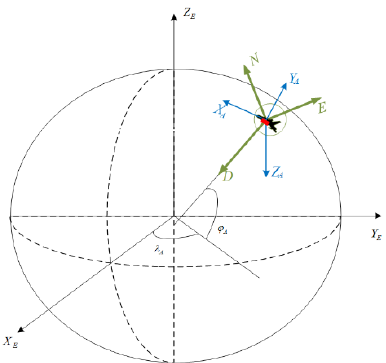
Figure 3. Schematic of ECEF coordinate system and NED coordinate system. The origin of the aircraft coordinate system (A) is the same as the origin of the geo- graphic coordinate system. The X -axis points to the nose, the Y -axis points to the right wing, and the Z -axis is vertical to the plane of the carrier plane. During the flight, the three-axis attitude is roll ( ϕ ), pitch ( θ ), and yaw ( ψ ), respectively. When the attitude angles of the three axes are all zero, the coordinate system of the carrier aircraft completely coincides with the geographic coordinate system. The relationship between the carrier coordinate system and the geographic coordinate system is shown in Figure 4, where LOS represents the direction of the camera’s visual axis (line of sight). The transformation matrix between the carrier coordinate system and the geographic coordinate system is indicated in Equation (10) [64].